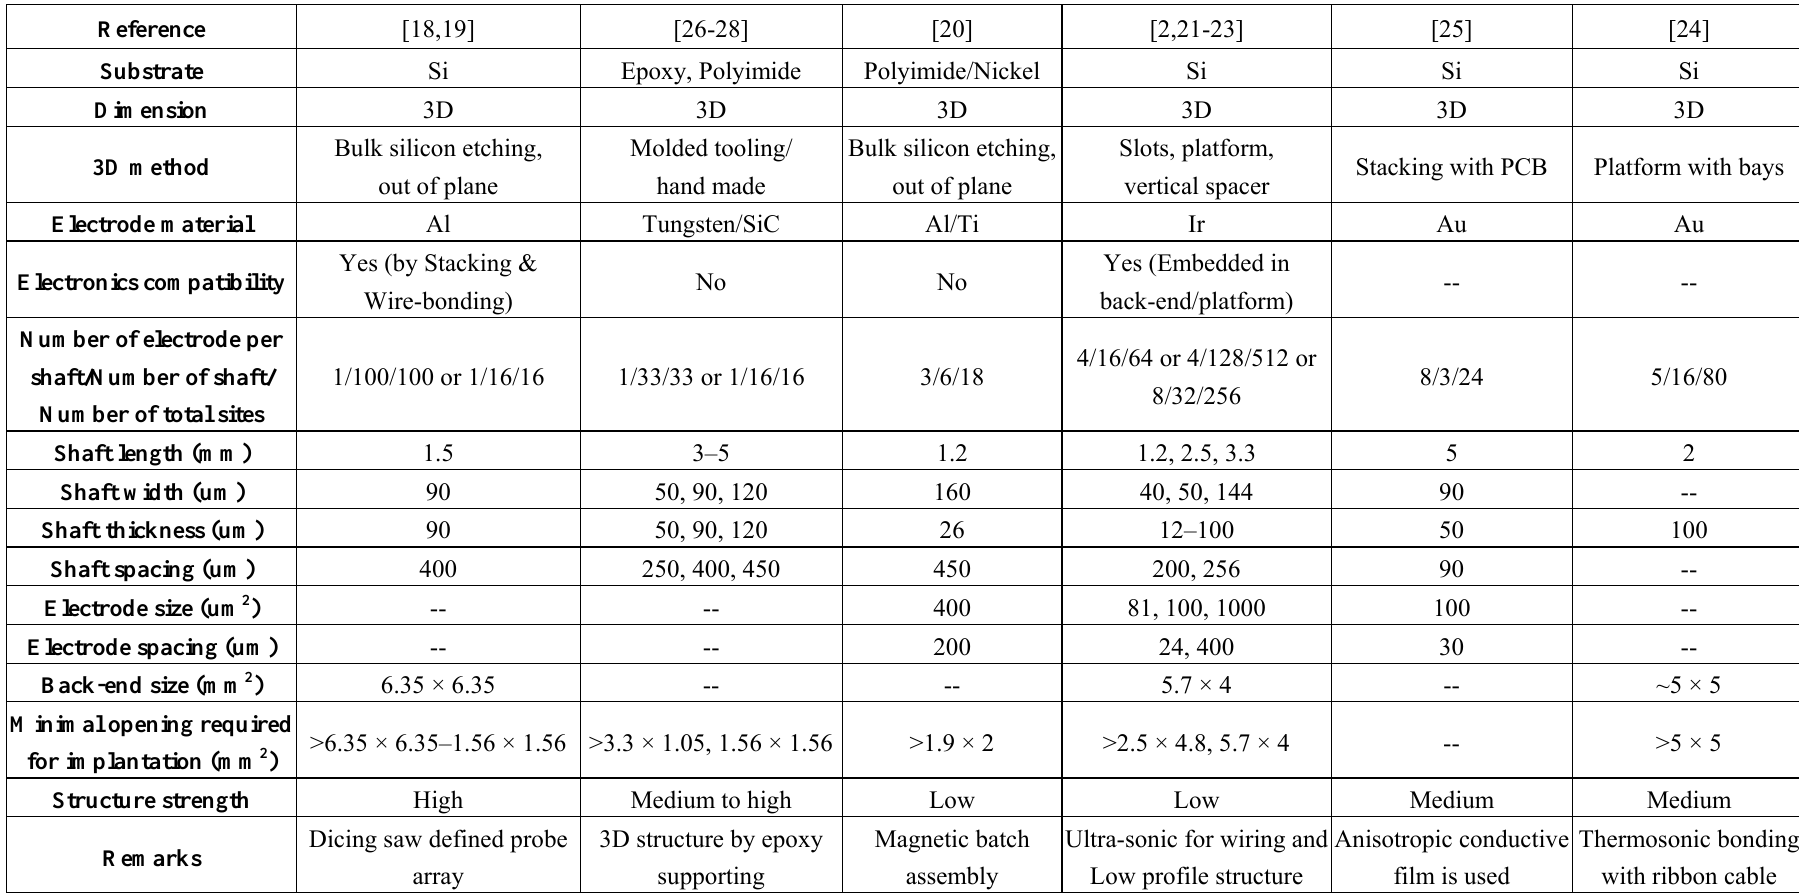
Table 1. Comparison of three-dimensional microprobe arrays with some major design